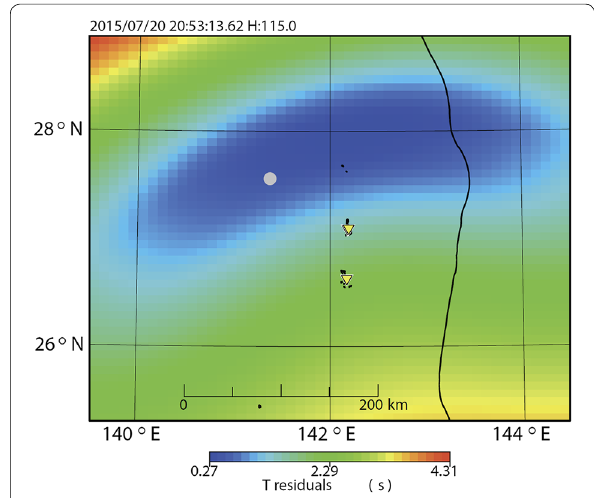
Fig. 7 An example of the travel-time residual distribution of an earthquake in SBJ. The gray circle indicates the hypocenter location, and the inverted yellow triangles show the locations of three stations situated on